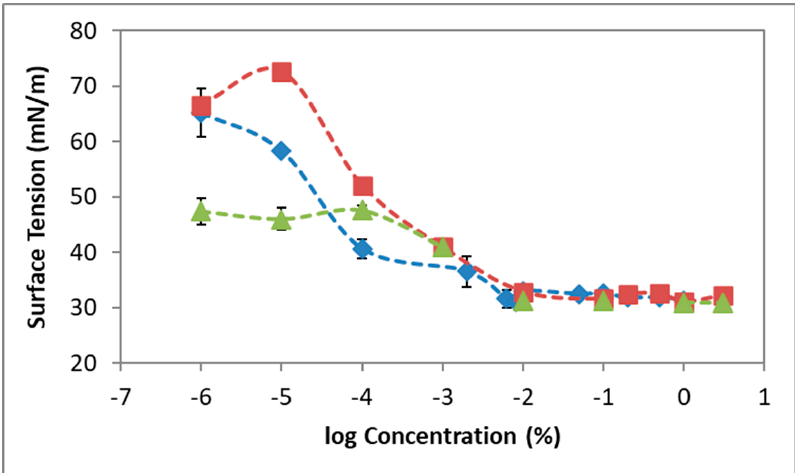
Figure 4. Surface tension values after 1 h of adsorption at constant surface area, 0.9% NaCl and T = 20 °C as a function of bulk concentration of POL. POL (blue rhombus), POL + 0.3% HA (red squares), and POL + 0.1 mM F68 (green triangles). Values plotted are mean values of three independent measurements, and standard deviations are plotted as error bars. Detailed statistical analysis of data is shown in Figure S3. Lines are a guide for the eye.